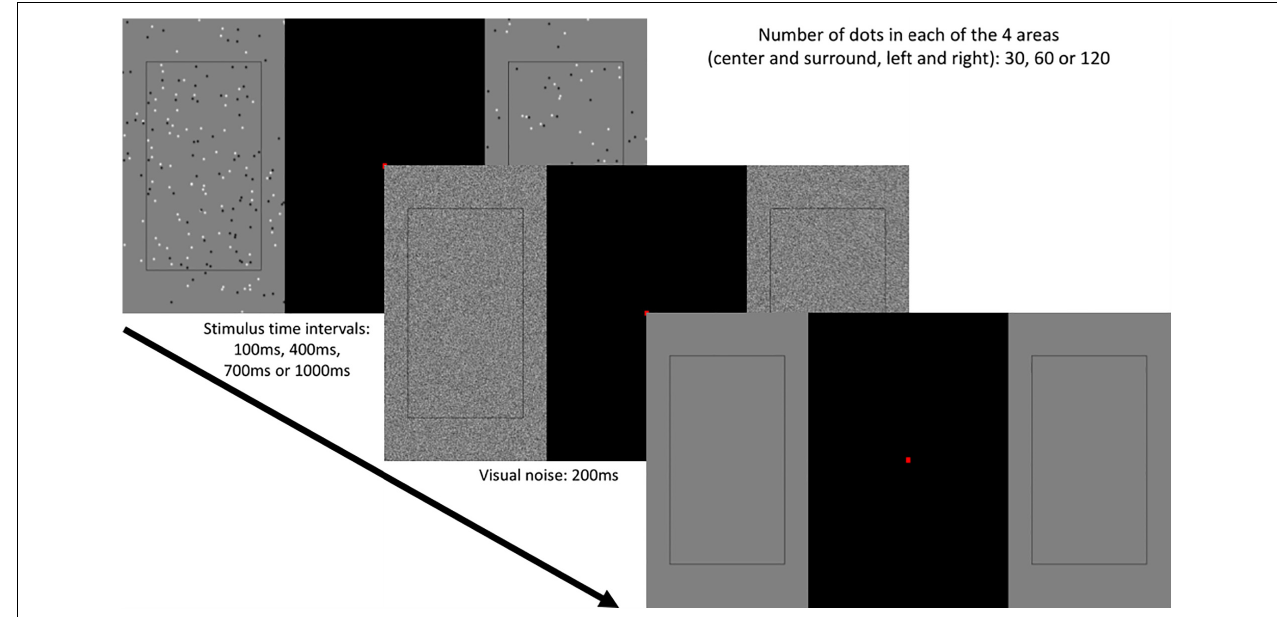
FIGURE 1 | Experimental protocol. For each trial, a varying number of dots was presented in left centre, left surround, right centre, right surround, for a varying duration: 100, 400, 700 or 1,000 ms. This was followed by brief visual white noise, after which the observers had to discriminate, for the relevant area, either left or right side presented more dots (Two- Alternative Forced